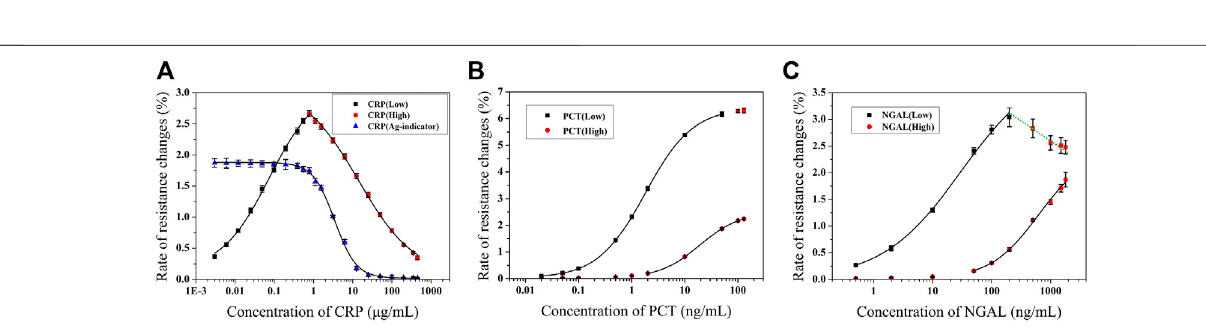
Frontiers in Chemistry |